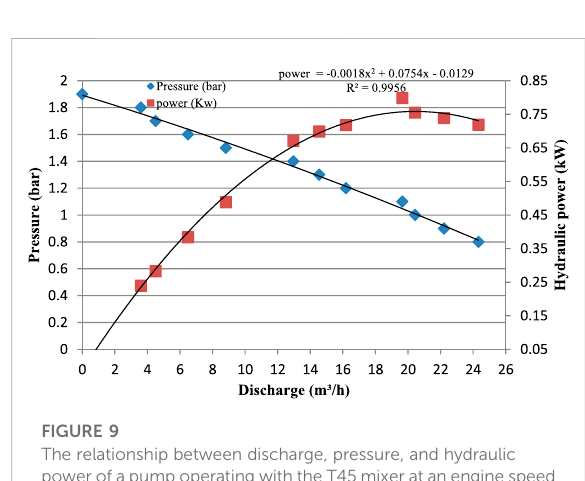
FIGURE 9 The relationship between discharge, pressure, and hydraulic power of a pump operating with the T45 mixer at an engine speed of 3,500